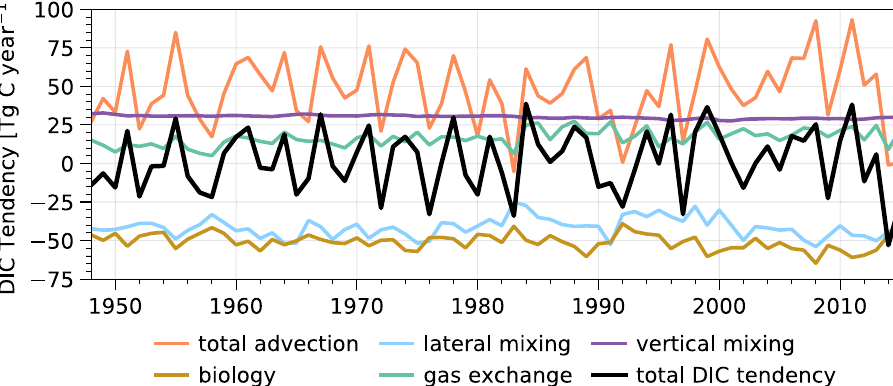
Fig. 7 Dissolved inorganic carbon budget of the California Current. Time series of the individual annual tendency terms of dissolved inorganic carbon (DIC) in the model reconstruction integrated over the California Current System laterally and to 150 m vertically (the approximate mean mixed layer depth in the model reconstruction). The colored lines show the individual terms, while the black line shows the total integrated DIC